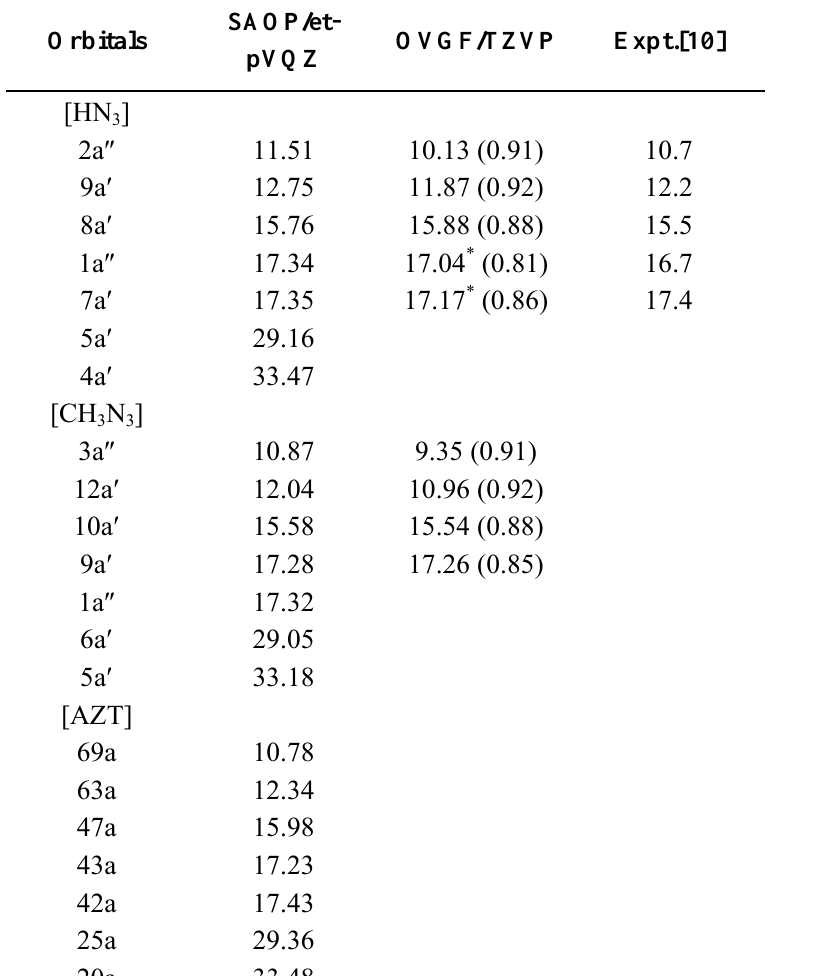
Table 4. Vertical ionization energies of AZT, CH SAOP/et-pVQZ and OVGF/TZVP models